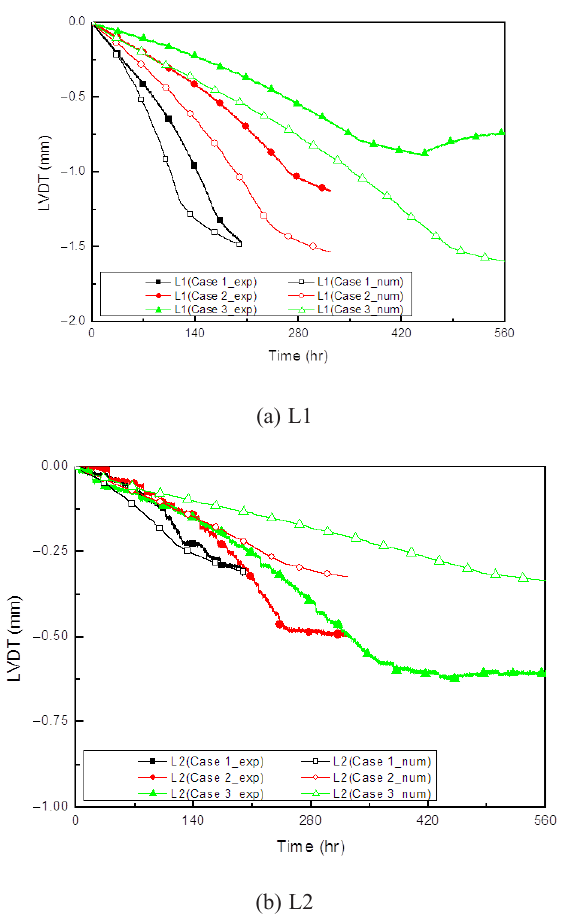
Fig. 12. Time histories of vertical displacements at rear side of levee obtained by numerical simulation and test (after 62.5 Fig. 13. Distributions of accumulated plastic deviatoric strain p γ with time (Case 1)